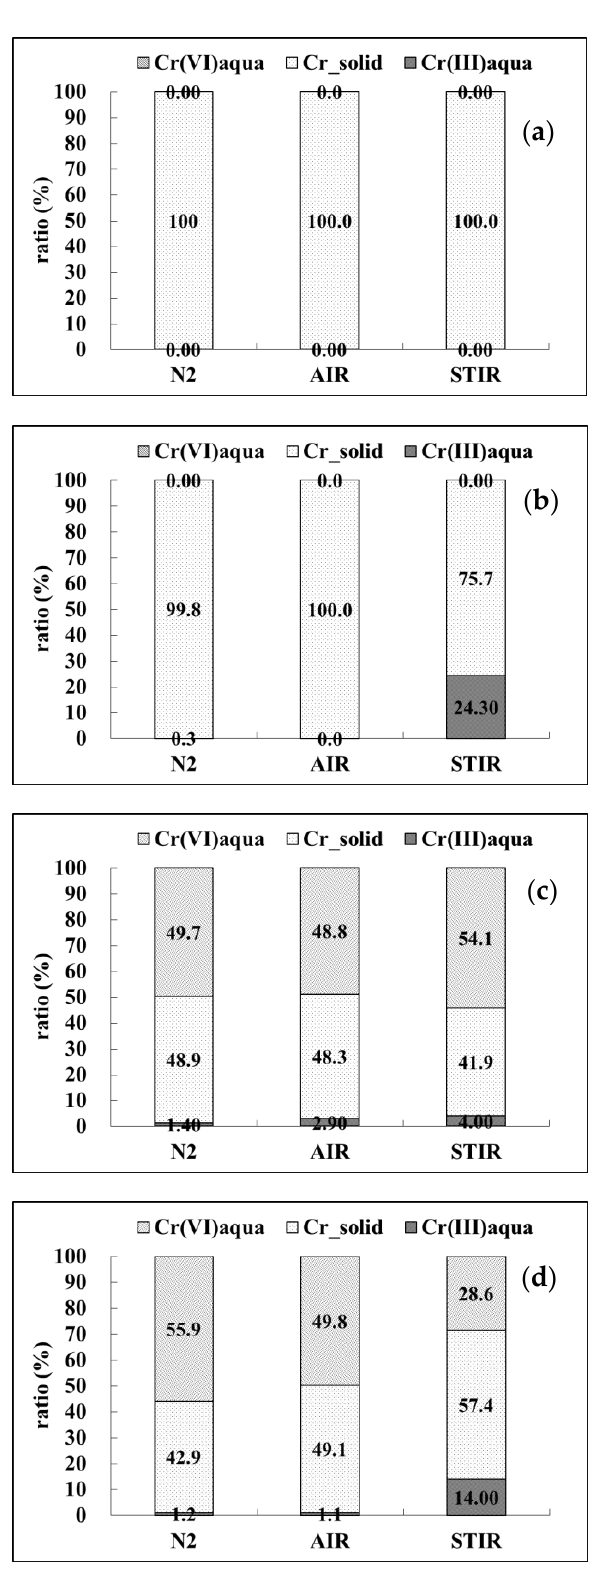
Figure 5. Effects of oxygen on chromium species distribution after photo-reduction by TiO 2 ( a ) Cr 3 mgL −1 alone, ( b ) 3 mgL −1 of Cr(VI) coupled with 10 mgL −1 of SA, ( c ) Cr 20 mgL −1 alone, and ( d ) 20 mgL −1 of Cr(VI) coupled with 10 mgL −1 of SA.